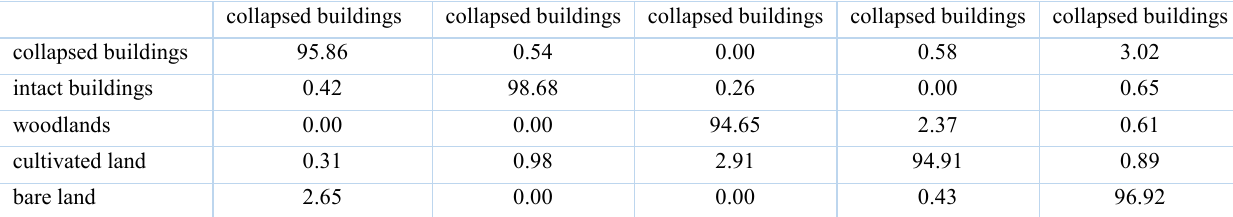
Table 4. Confusion matrices obtain by Spectral-AlexNet features by Method